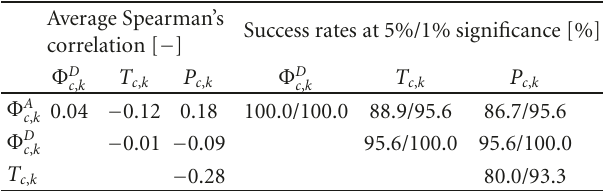
Table 1: Average Spearman’s correlation of MPC parameters within each cluster and success rates for zero